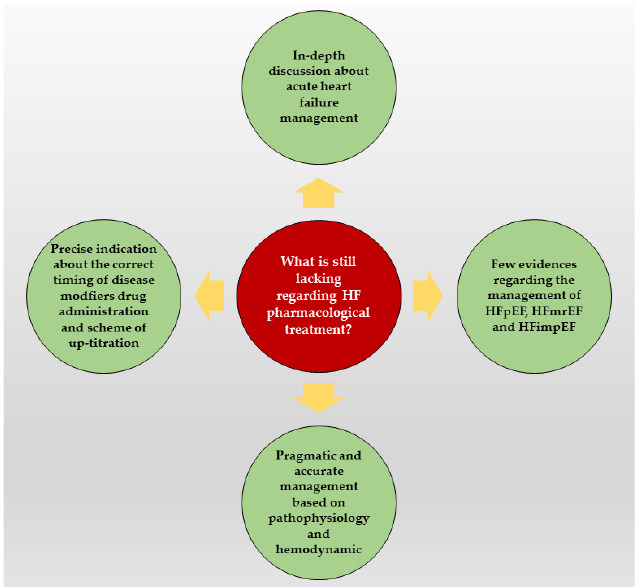
Figure 1. Main current gaps in heart failure pharmacological treatment. HF: heart failure; HFmrEF: heart failure with mildly reduced ejection fraction; HFpEF: heart failure with preserved ejection fraction; HFimpEF: heart failure with improved ejection fraction.